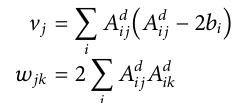
Frontiers in Mechanical Engineering |